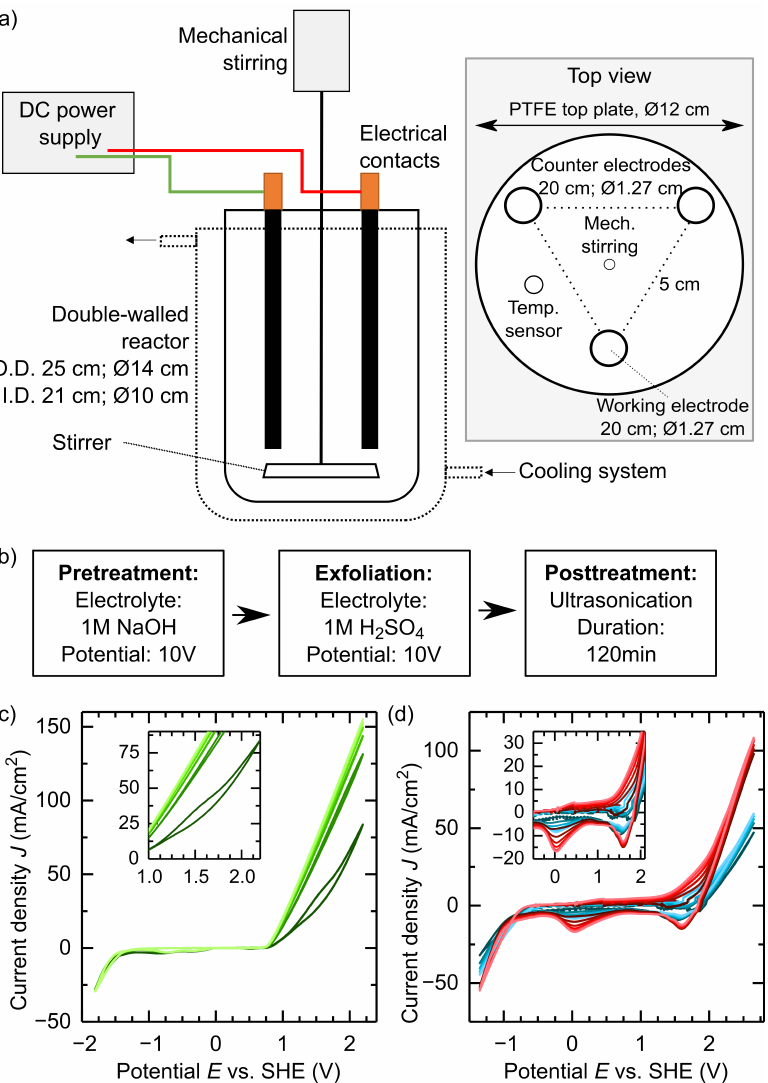
Figure 1. ( a ) Front (left) and top (right) sides of the electrochemical exfoliation set-up. The lateral view shows the cooling system and the power supply while the top view pictures the electrodes’ position in the electrochemical reactor. The dimensions refer to a 1600 mL reactor. ( b ) Production protocol for the up-scaling process with anodic pretreatment in 1 M NaOH. ( c ) Cyclic voltammetry applied to a graphite rod in 1 M NaOH (scan rate 10 mV/s; 6 cycles: dark green to light green). ( d ) Cyclic voltammetry applied to a graphite rod in 1 M H 2 SO 4 (scan rate 10 mV/s; 6 cycles: dark color to light color). Red indicates an untreated graphite rod and blue a graphite rod pretreated anodically in 1 M NaOH for 10